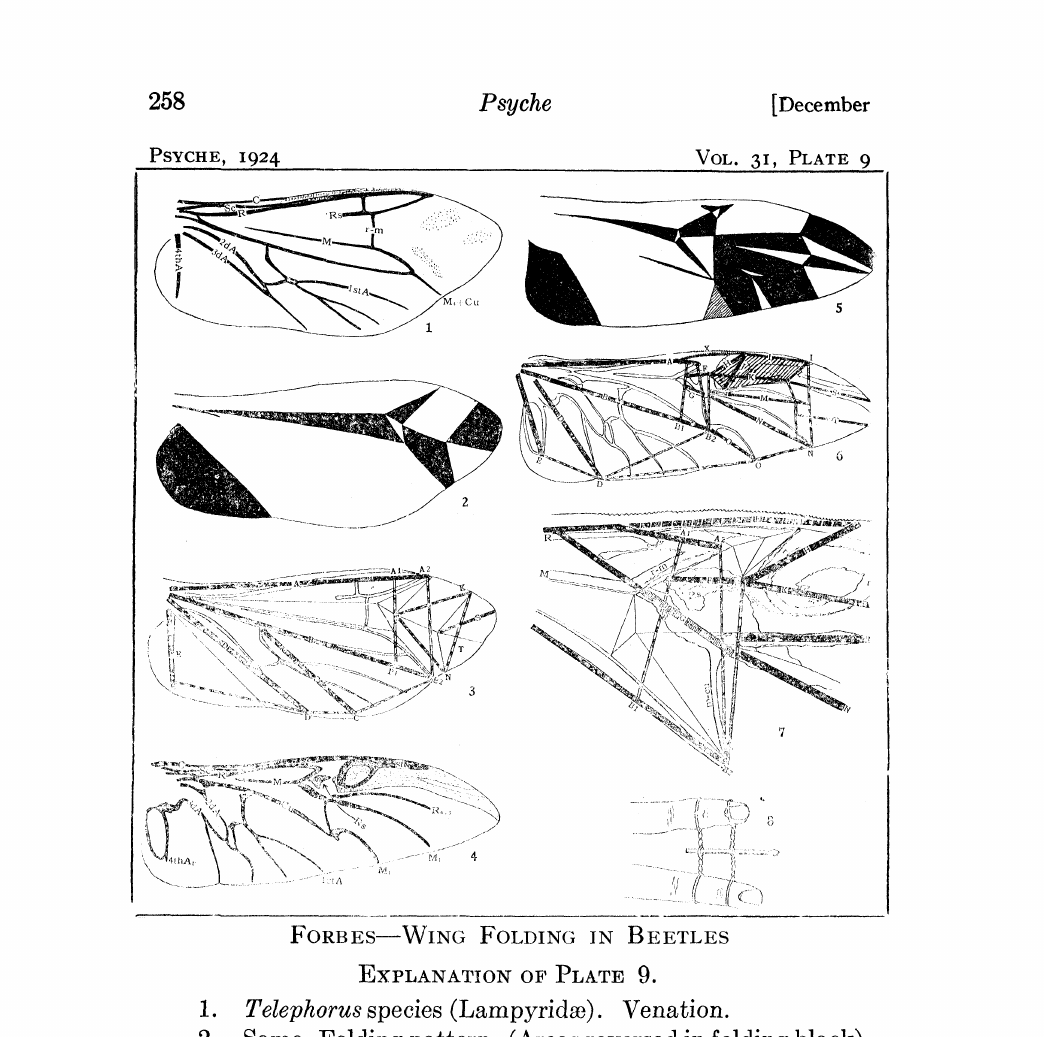
(Lines of stiffness are represented by heavy solid lines, lines of tension by